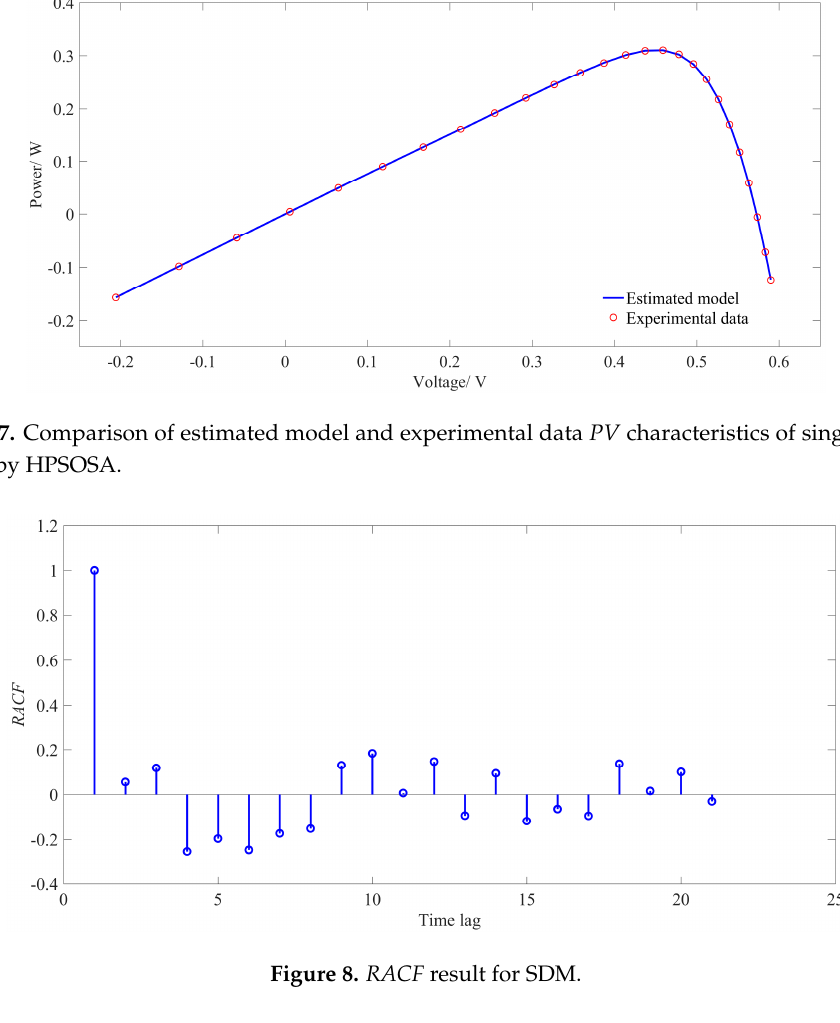
model by the HPSOSA.